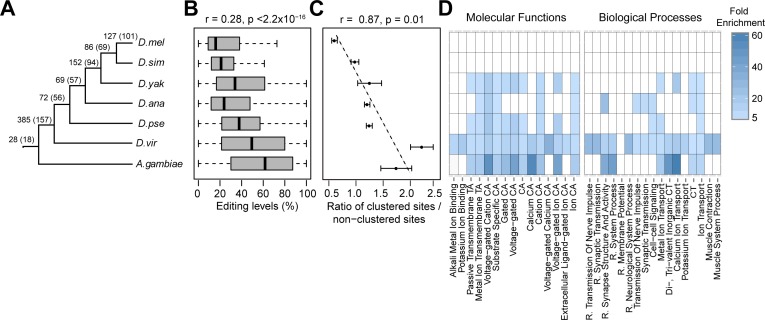
Characterization of the evolution and function of edited genes.(A-D) The relationship between age of editing sites and editing levels, the degree of clustering, and gene function. (A) Depiction of the species and age groups analyzed; numbers above the branches denote the numbers of D.mel editing sites in each age group and numbers in parentheses denote the numbers of genes in each age group. (B) The relationship between age of editing sites and their representative editing levels. Spearman's ρ is indicated. (C) The relationship between age of editing sites and the degree of clustering. We defined a site as clustered if the neighboring site is within a certain distance (30, 40, and 50bp). Error bars, standard deviation. (D) The relationship between age of editing sites and function of edited genes. CT: Cation Transport; R.: Regulation of; CA: Channel Activity; TA: Transporter Activity.